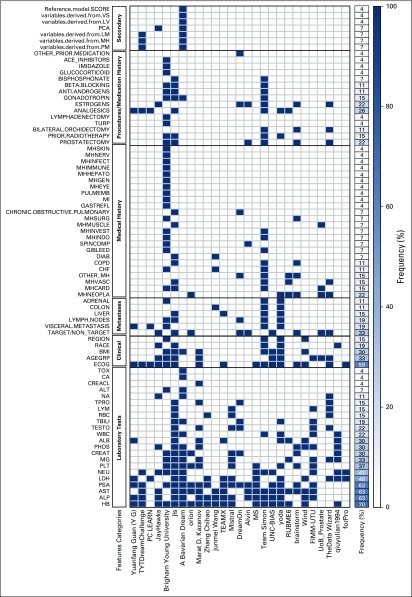
Most frequent clinical features used across all prediction models. Abbreviated terms are provided in the Data Supplement.